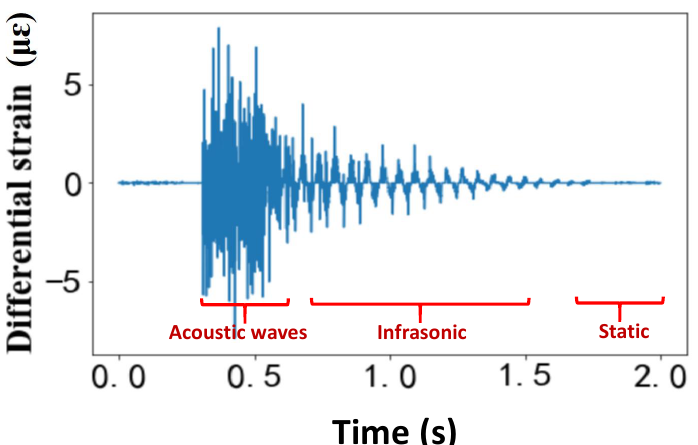
Figure 1. Expected differential strain variations of the steel I-beam due to the impact